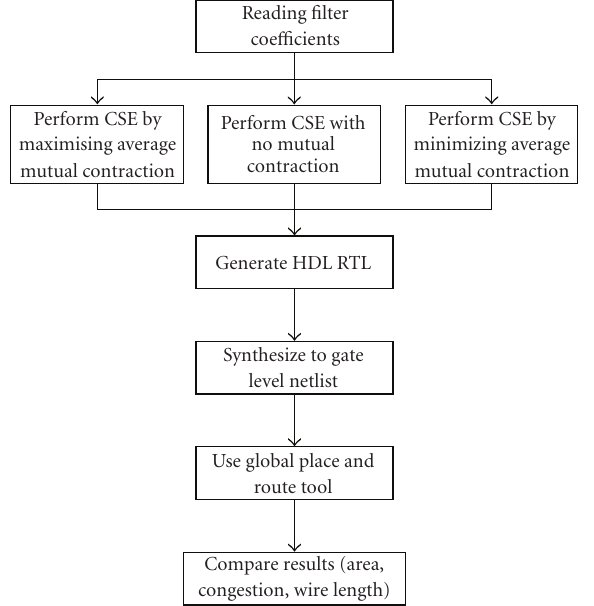
Figure 16: Implementation flow using mutual contraction concept.